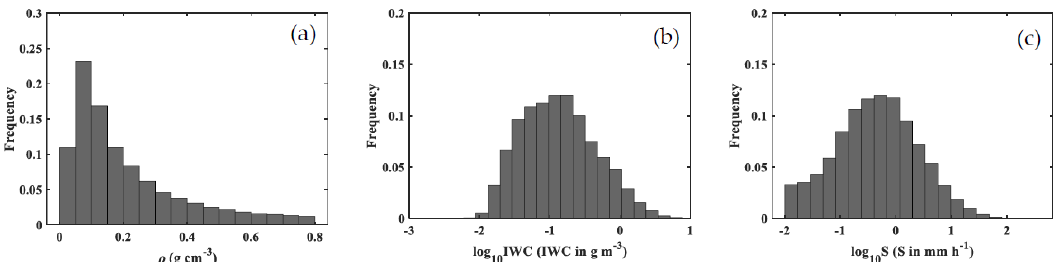
Figure 3. Histograms of snow PSD parameters for total snowfall events: ( a ) the density of snow, ρ (g cm − 3 ); ( b ) ice water content, log 10 IWC ( IWC in g m −3 ); ( c ) liquid water equivalent snowfall rates, log 10 S ( S in mm h − 1 ). Table 2. Statistics of snow PSD parameters for total snowfall events: ρ (g cm − 3 ), log 10 IWC ( IWC in g m − 3 ) and log 10 S ( S in mm h − 1